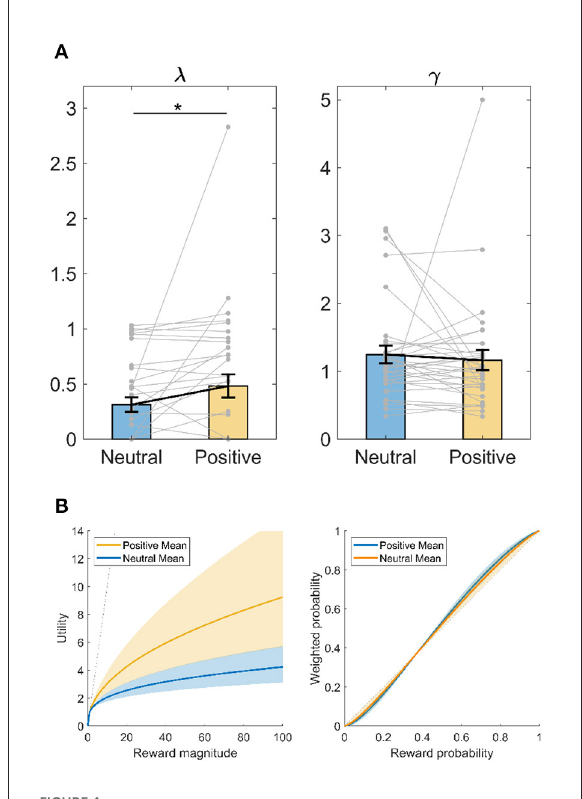
FIGURE4 Intervention effect on decision-making parameters using maximum likelihood method. (A) Utility sensitivity λ and probability weighting γ . * p < 0.05, Wilcoxon signed-rank test. Data shown as mean ± SE. (B) Illustration of the utility and probability weighting function changes after positive memory retrieval, plot with the mean ± SE of each parameter. Left panel, utility (u) as a function of reward magnitude (x). Right panel: decision weight (w) as a function of objective probability ( p ). The dashed line represents linear utility or probability